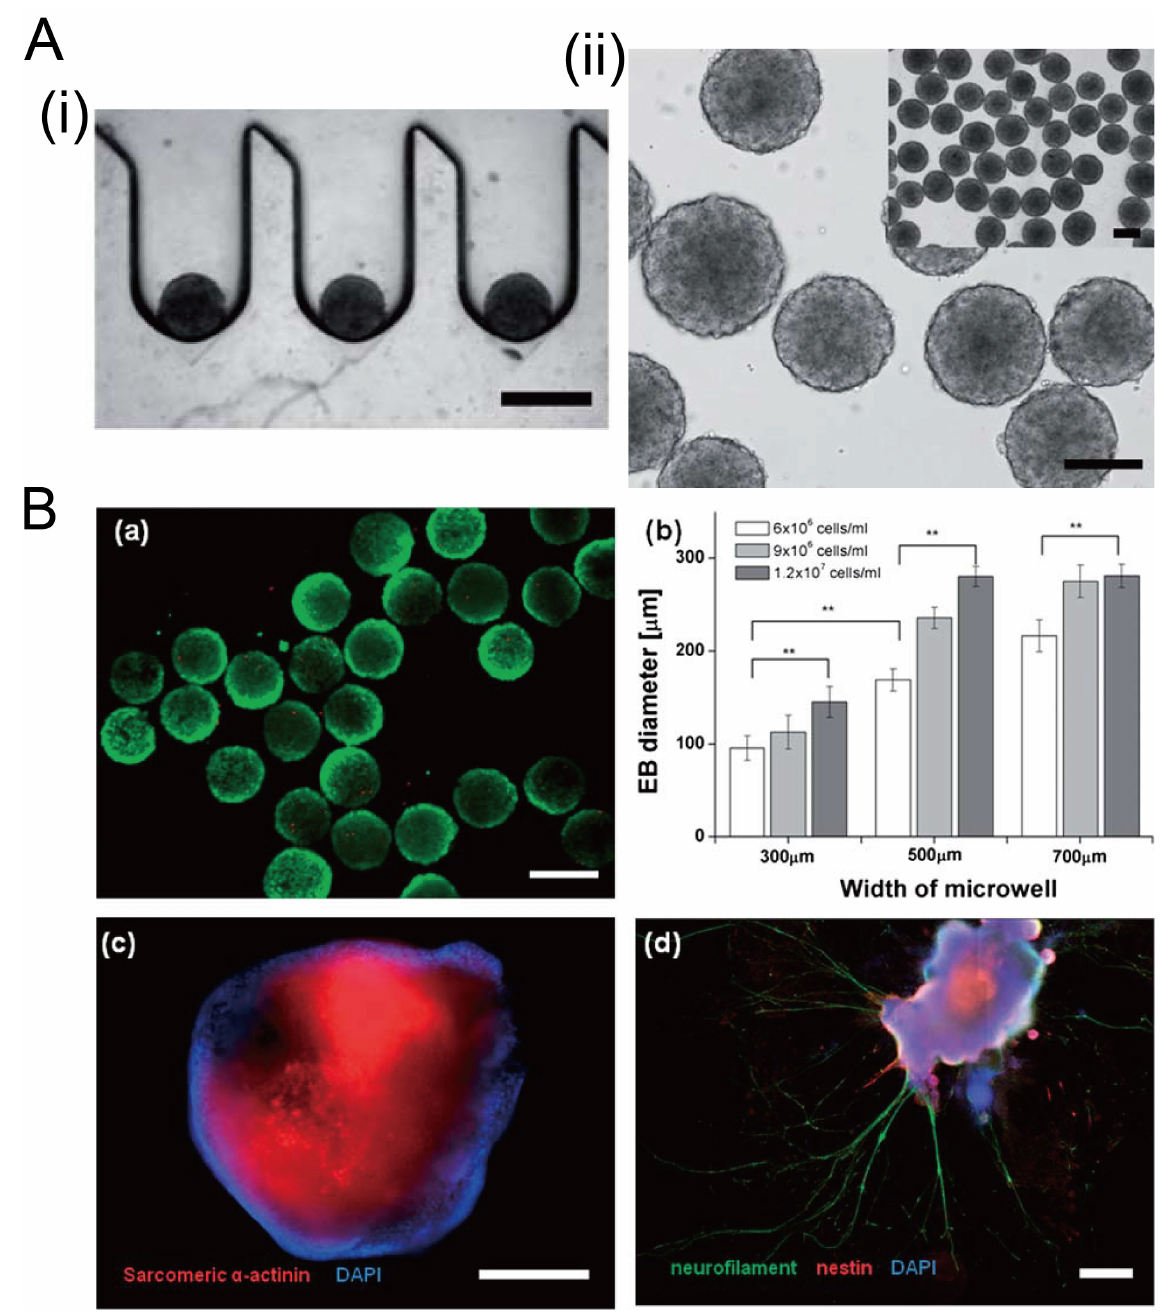
Figure 20. Formation of embryoid bodies in deep concave microwells [98]. ( A ) Cross-section view of embryoid stem cell aggregates in concave microwells (i), and top view of embryoid stem cell aggregates (ii). Scale bars: 400 µm. ( B ) Fluorescent images of embryoid bodies with green indicating the live cells (a), the relation of embryoid body size with the width of microwell and the seeding density (b), fluorescent images of embryoid bodies with sarcomeric a-actinin and nucleus stained to show the cardiac differentiation (c), fluorescent images of embryoid bodies with neurofilament, nestin, and nucleus stained to show the neuroepithelial differentiation (d). ** p < 0.01. Scale bar in (a) shows 300 µm, and scale bars in (c) and (d) show 400 µm. Reprinted (adapted) from [98]. Copyright (2012) with permission from Royal Society of